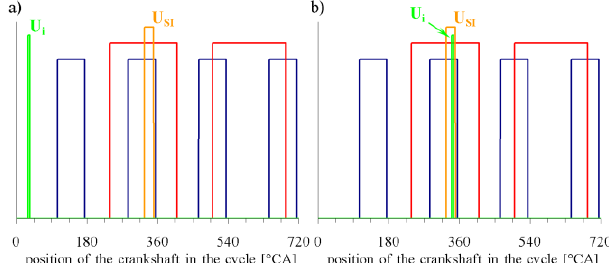
Fig. 1. Waveforms in the direct fuel injection system, when the mixture is formed: a) homogeneous, b) stratified The navy blue waveforms show impulses from the crankshaft position sensor, while the red ones show the pulses from the camshaft position sensor. Based on these, it was possible to scale the axis of the angular position of the crankshaft for the first cylinder. The duty cycle begins when the piston is at TDC before its fill stroke and the crankshaft is assigned an angle of 0°CA. Completion of the duty cycle occurs when the piston reaches TDC after the exhaust stroke and the crankshaft is assigned an angle of 720°CA.